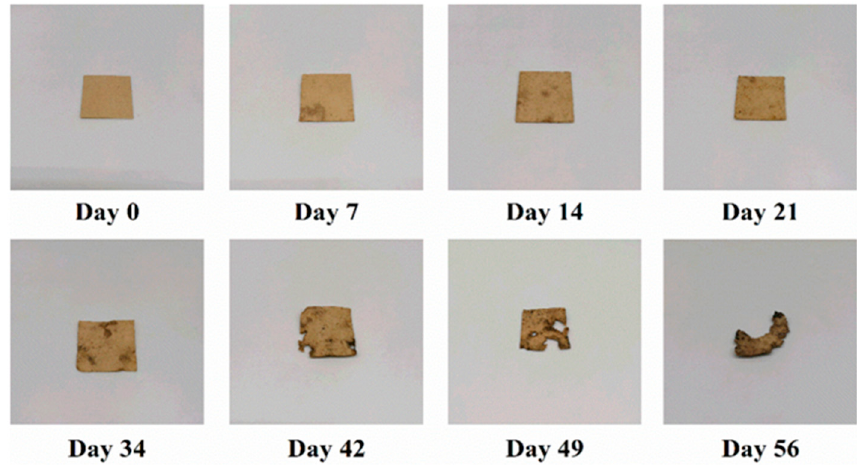
Figure 3. Macroscopic images of environment-friendly bamboo fiber lunch box in different degra- dation stages.